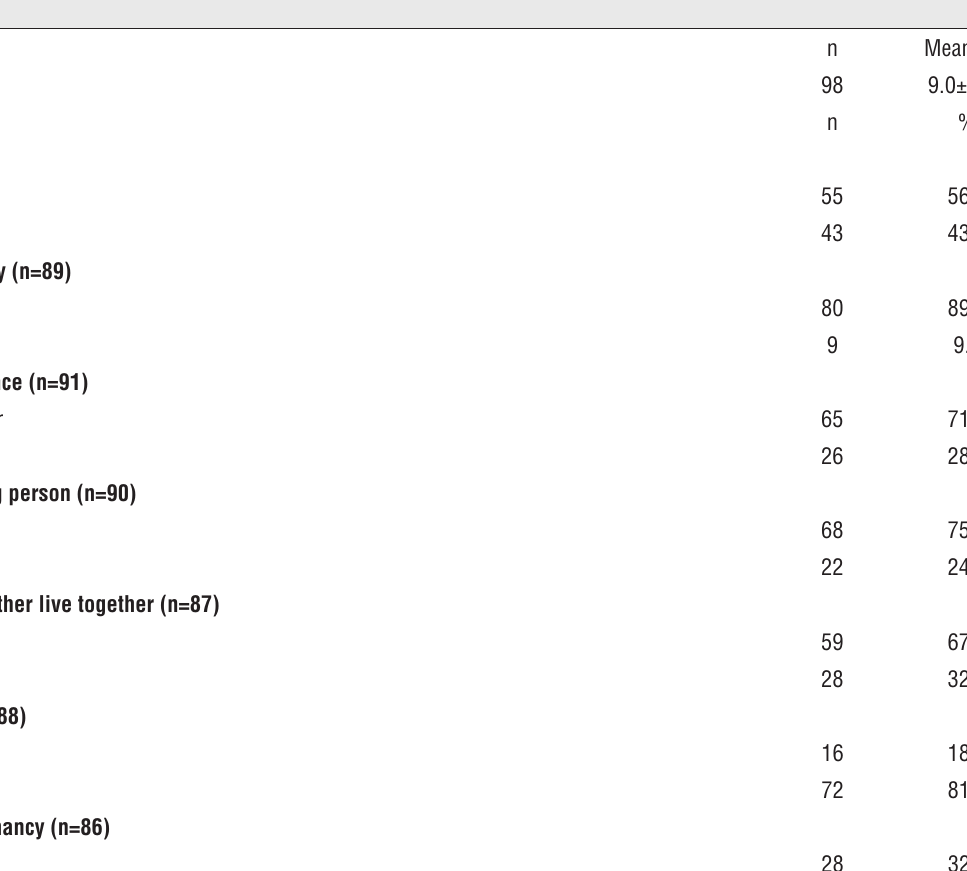
Table 1 - Characteristics of the children and adolescents participating in the study.